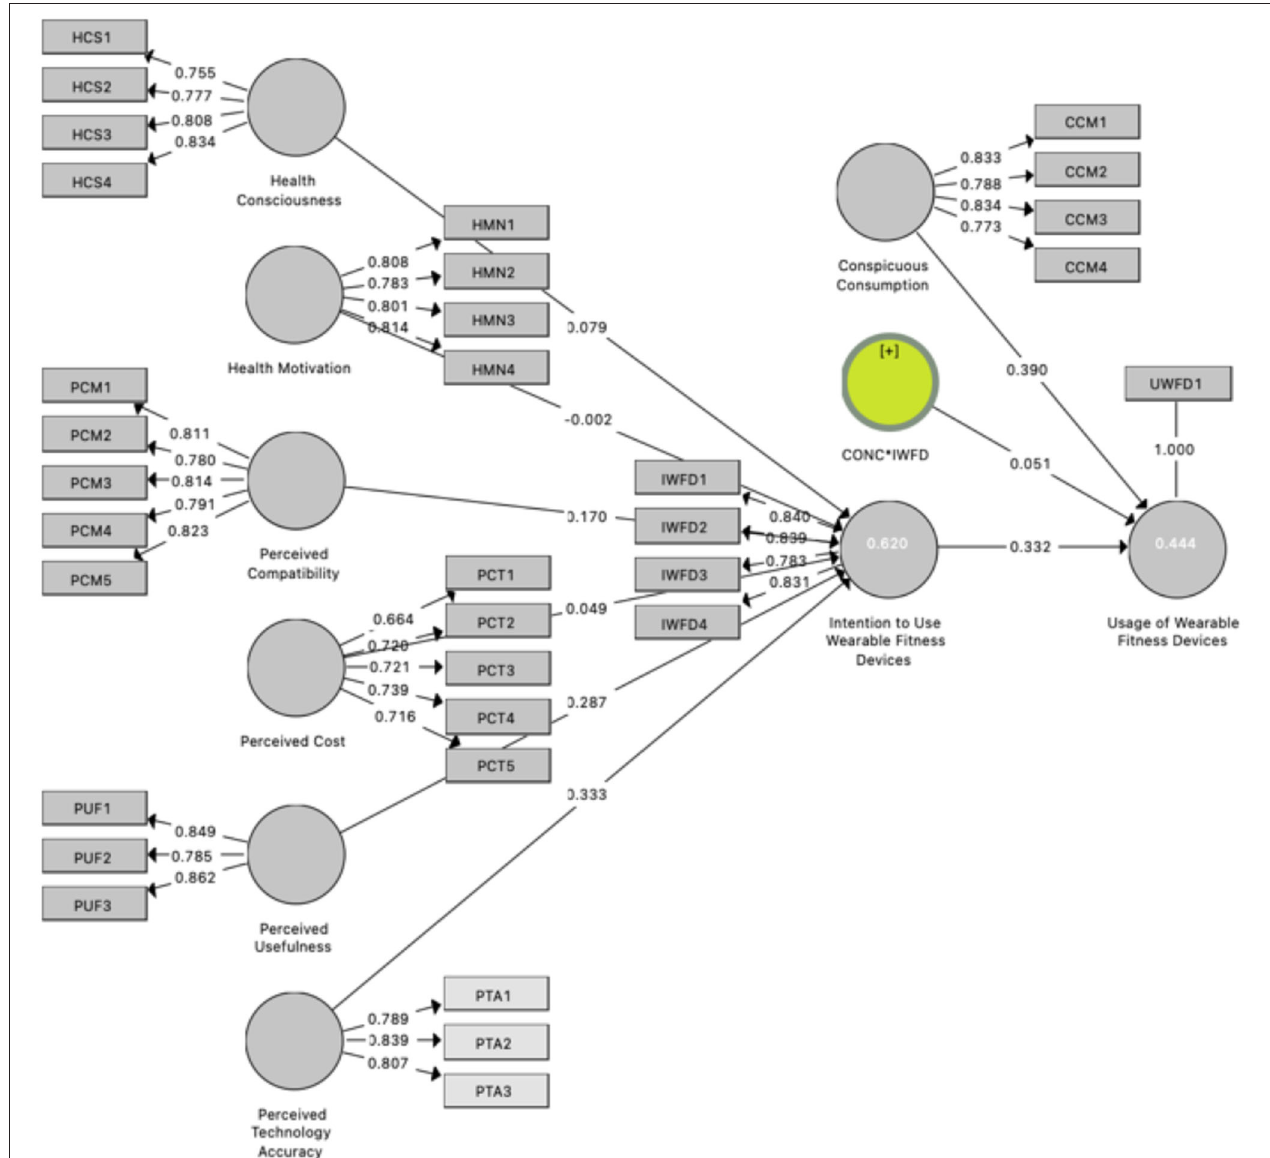
FIGURE 2 | Structural model with path